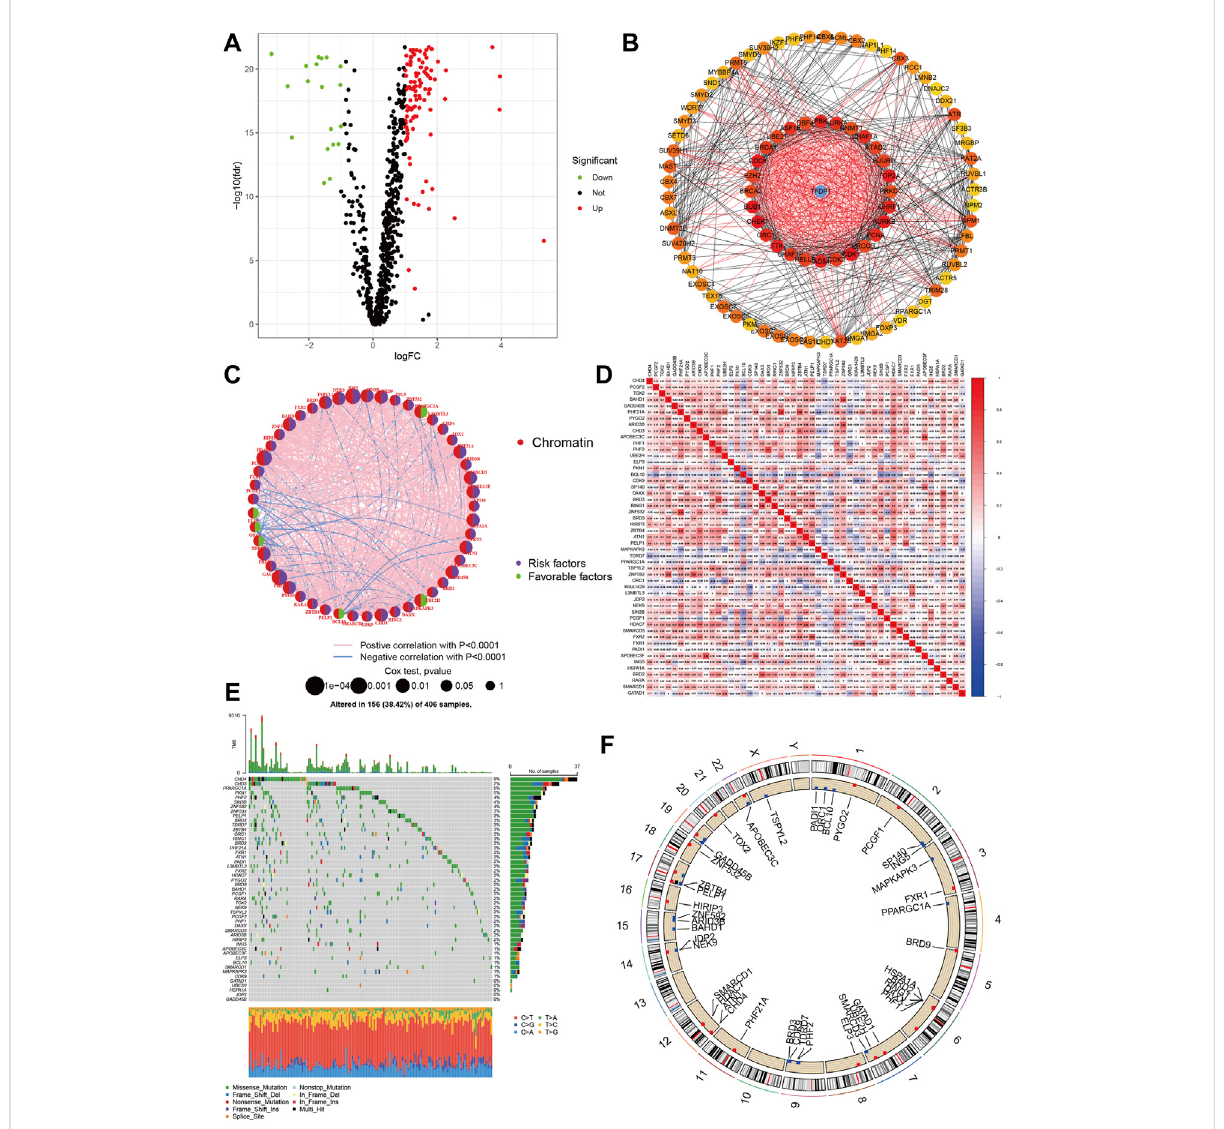
FIGURE 2 Landscapes of chromatin regulators in COAD. (A) Volcano showed the differential expression of chromatin regulators between tumor and normal samples. (B) Protein-protein interaction network ofchromatin regulators. (C) Prognosisroles ofchromatinregulators inCOAD. (D) Heatmap showed the correlations among chromatin regulators. (E,F) : Gene alteration levels of chromatin regulators in